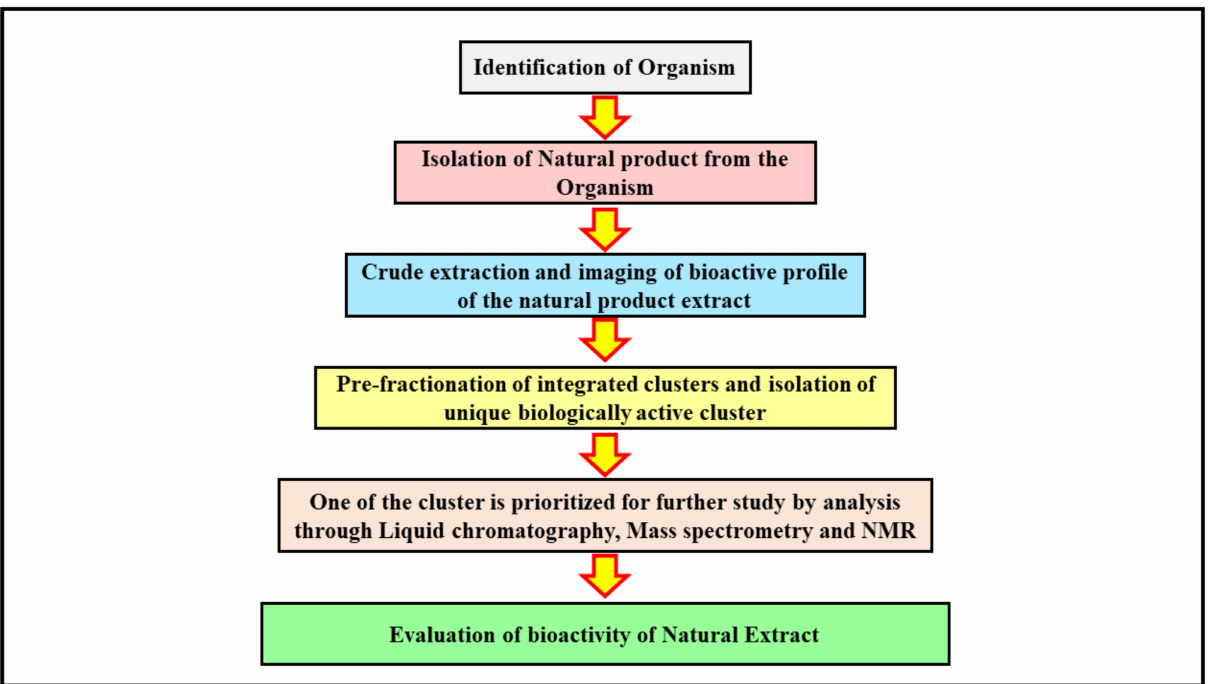
Figure 1. The figure illustrates the process of isolation of a bioactive molecule from a marine